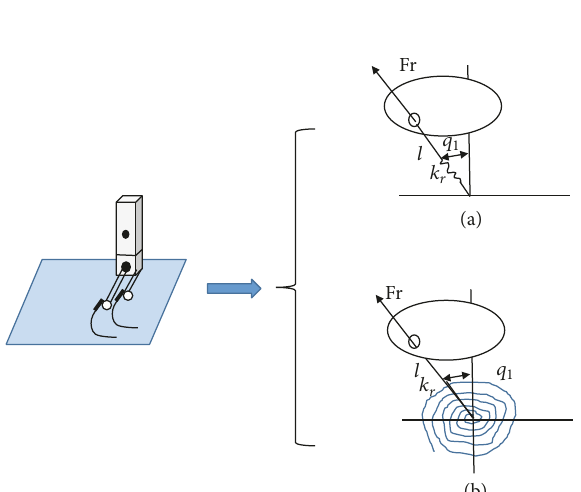
Figure 5: Mathematical model of AR.